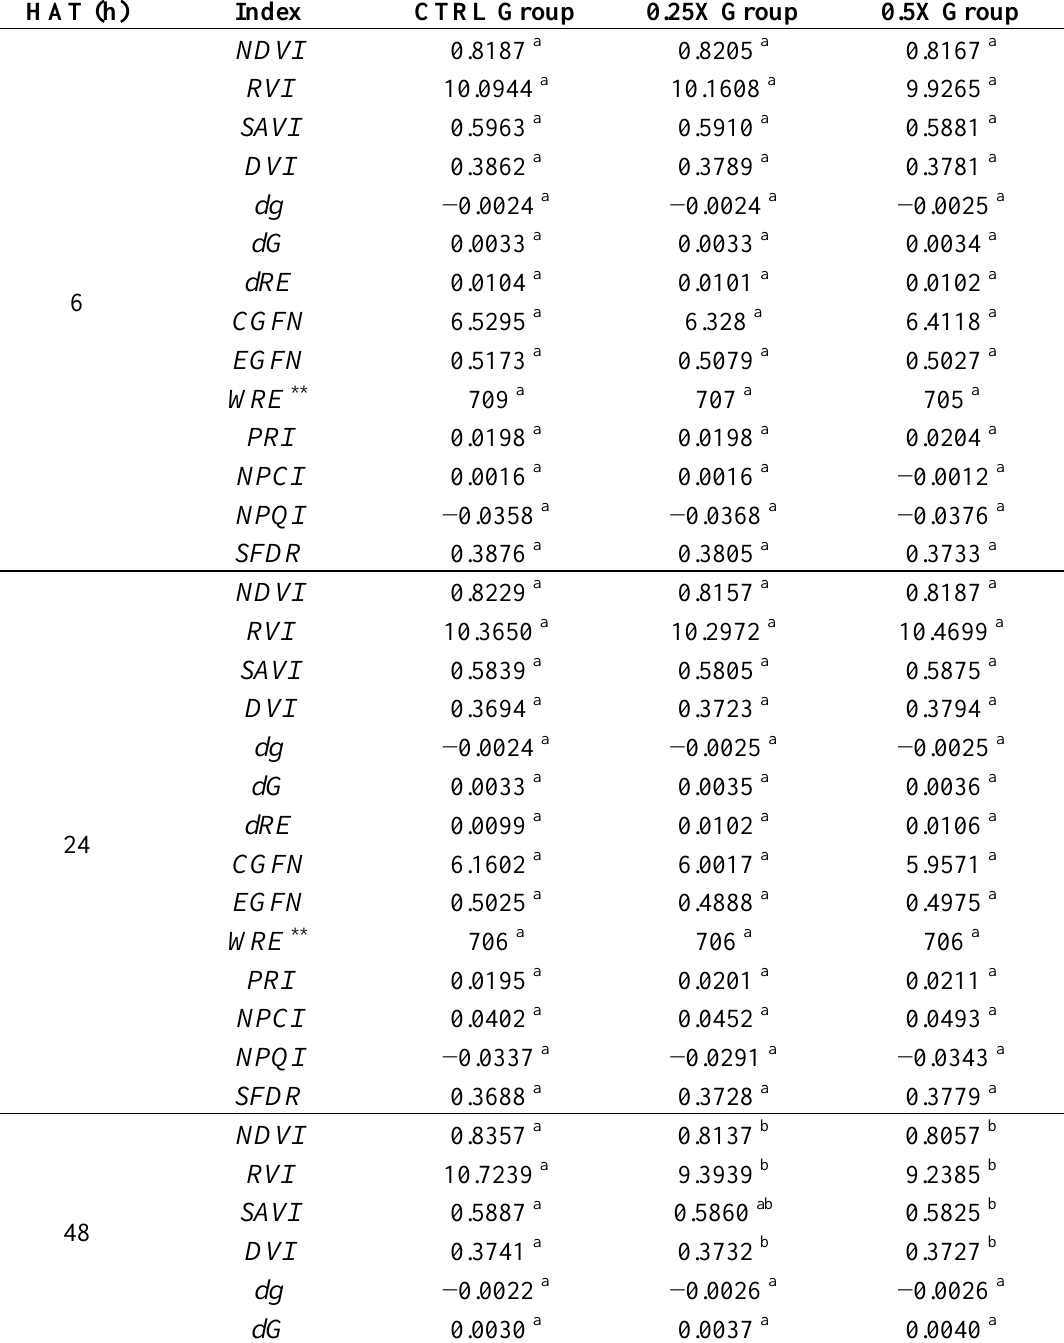
Table 4. Calculated spectral indices of the three groups of soybean leaves at 6, 24, 48, 72 HAT. Each value is a mean of six leaves. The separation results are based on the Duncan’s multiple range test.